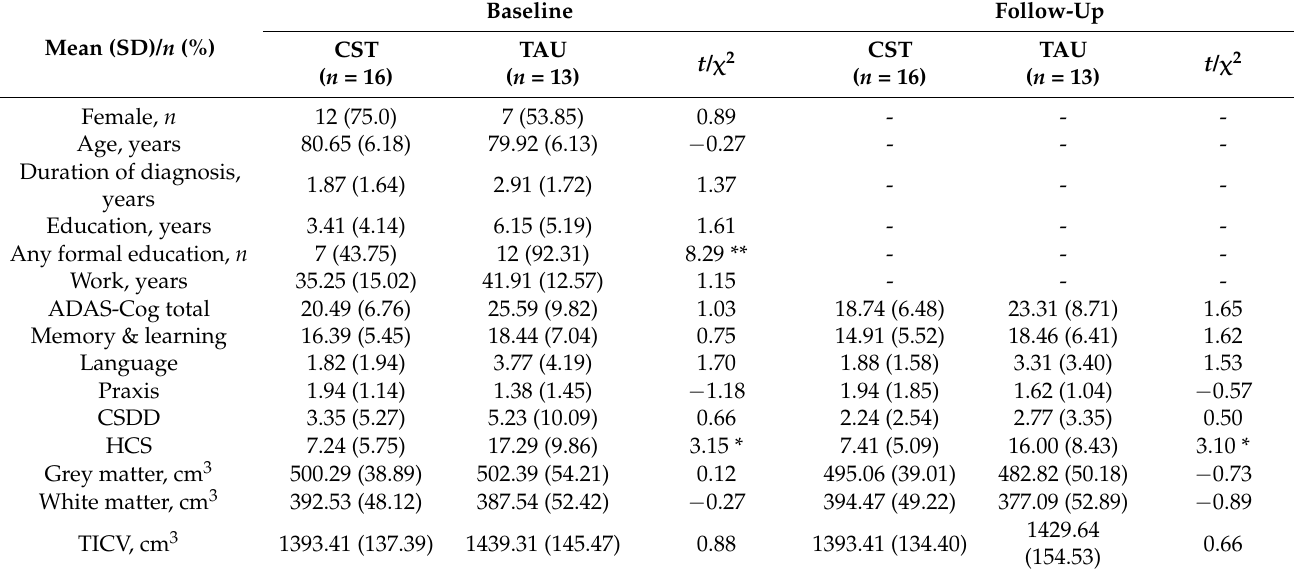
Table 1. Baseline and follow-up demographic characteristics, cognitive reserve proxies, and